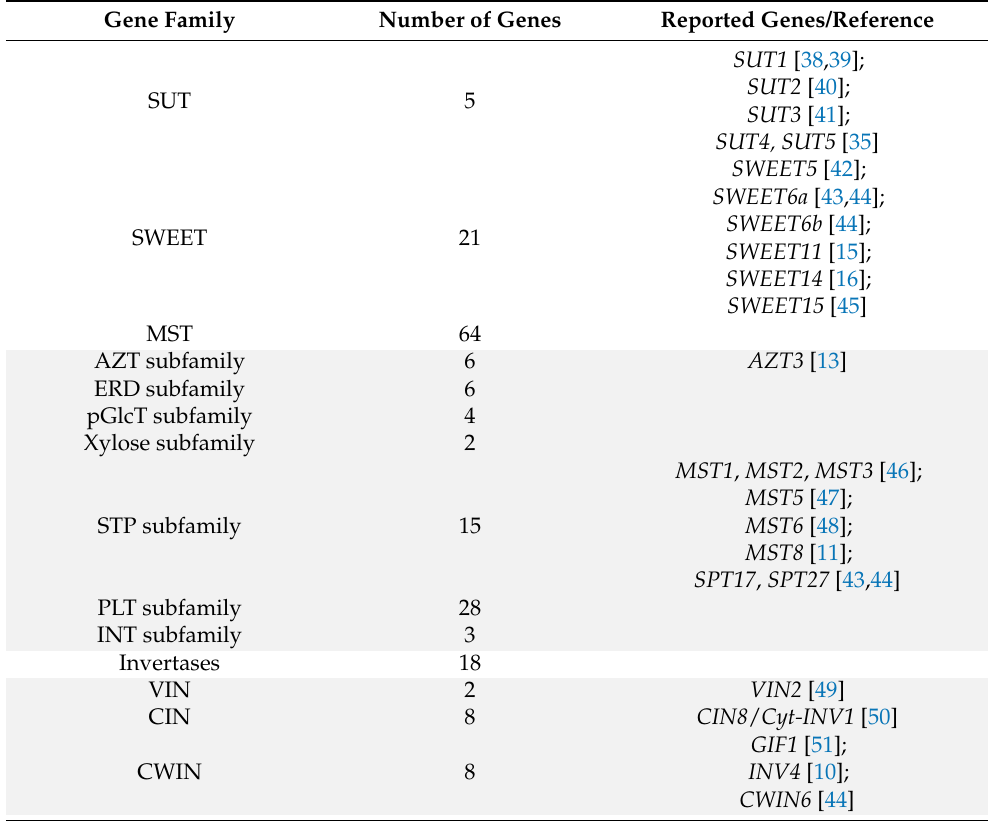
Table 1. Proteins involved in sugar metabolism in